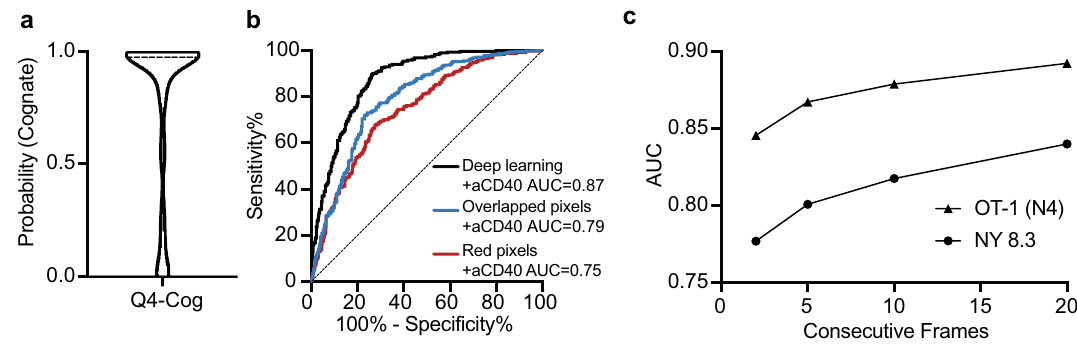
Figure 4. +aCD40 deep learning model trained on one set of interacting T cells and DCs accurately classifies other sets of interacting T cells and DCs. ( a ) Testing of the + aCD40 deep learning model (previously trained on videos of OT-I T cells interacting with un-pulsed, or high affinity N4 peptide-pulsed DCs (N4-DCs)) on T cells interacting with DCs presenting the lower affinity Q4 peptide. ( b ) ROC curves quantifying the ability of the +aCD40 deep learning model, overlapped pixels and red pixels to classify cognate or non-cognate NY8.3 T cells (cultured with aCD40). ( c ) Assessment of the ability of the deep learning model to classify high affinity cognate- and non-cognate OT-I and NY8.3 T cells when trained and tested on videos of varying